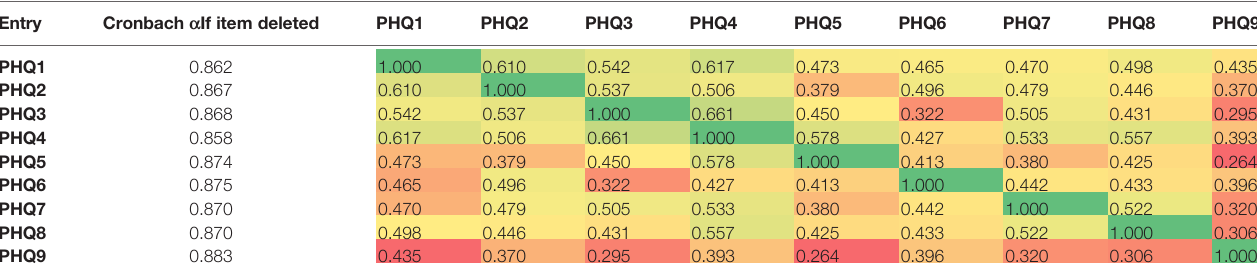
TABLE 5 | Validity test of GAD-7, PHQ-9 and SF-12.